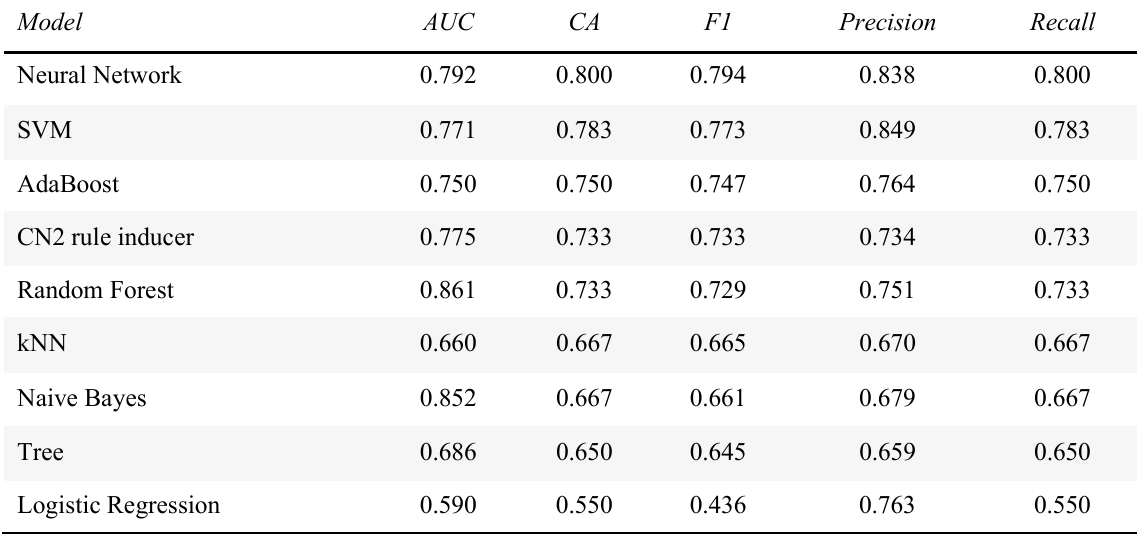
Figure 4. Implementation of microbial taxa implicated in second principal components accurately predict tumor presence. ( A ) Using Orange3, 10-fold stratified shuffle splits were performed. ( B ) Using a prediction signature which included Bacteroidales.f__S24.7 , Ruminococcaceae , and Clostridiales , implicated in the second principal components, resulted in an average accuracy of 80% achieved with a Neural Network classifier. AUC, area under the curve; CA, classification accuracy; F1, F1 score).